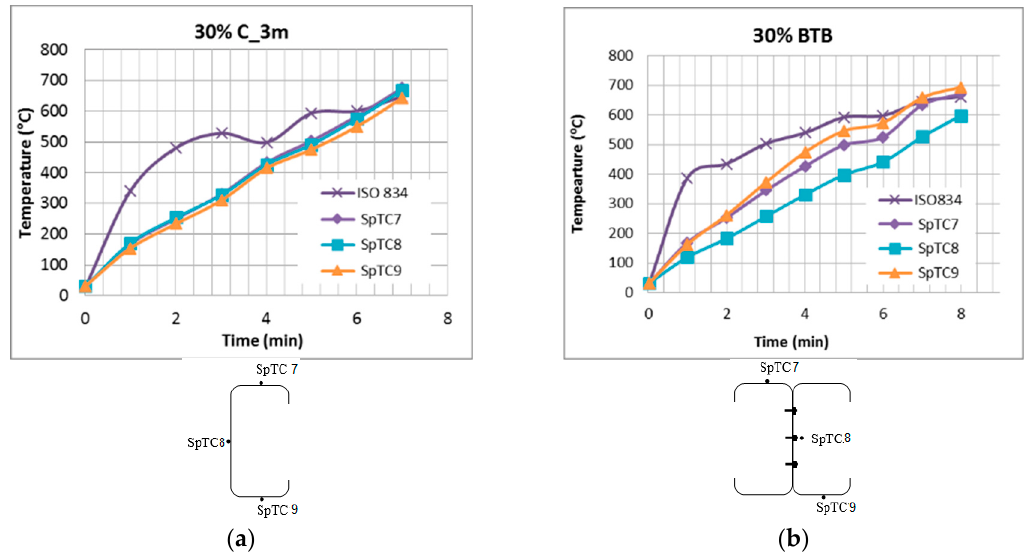
Figure 8. Time and temperature at TL3 of CFS unrestraint ( a ) channel; ( b ) back-to-back column.